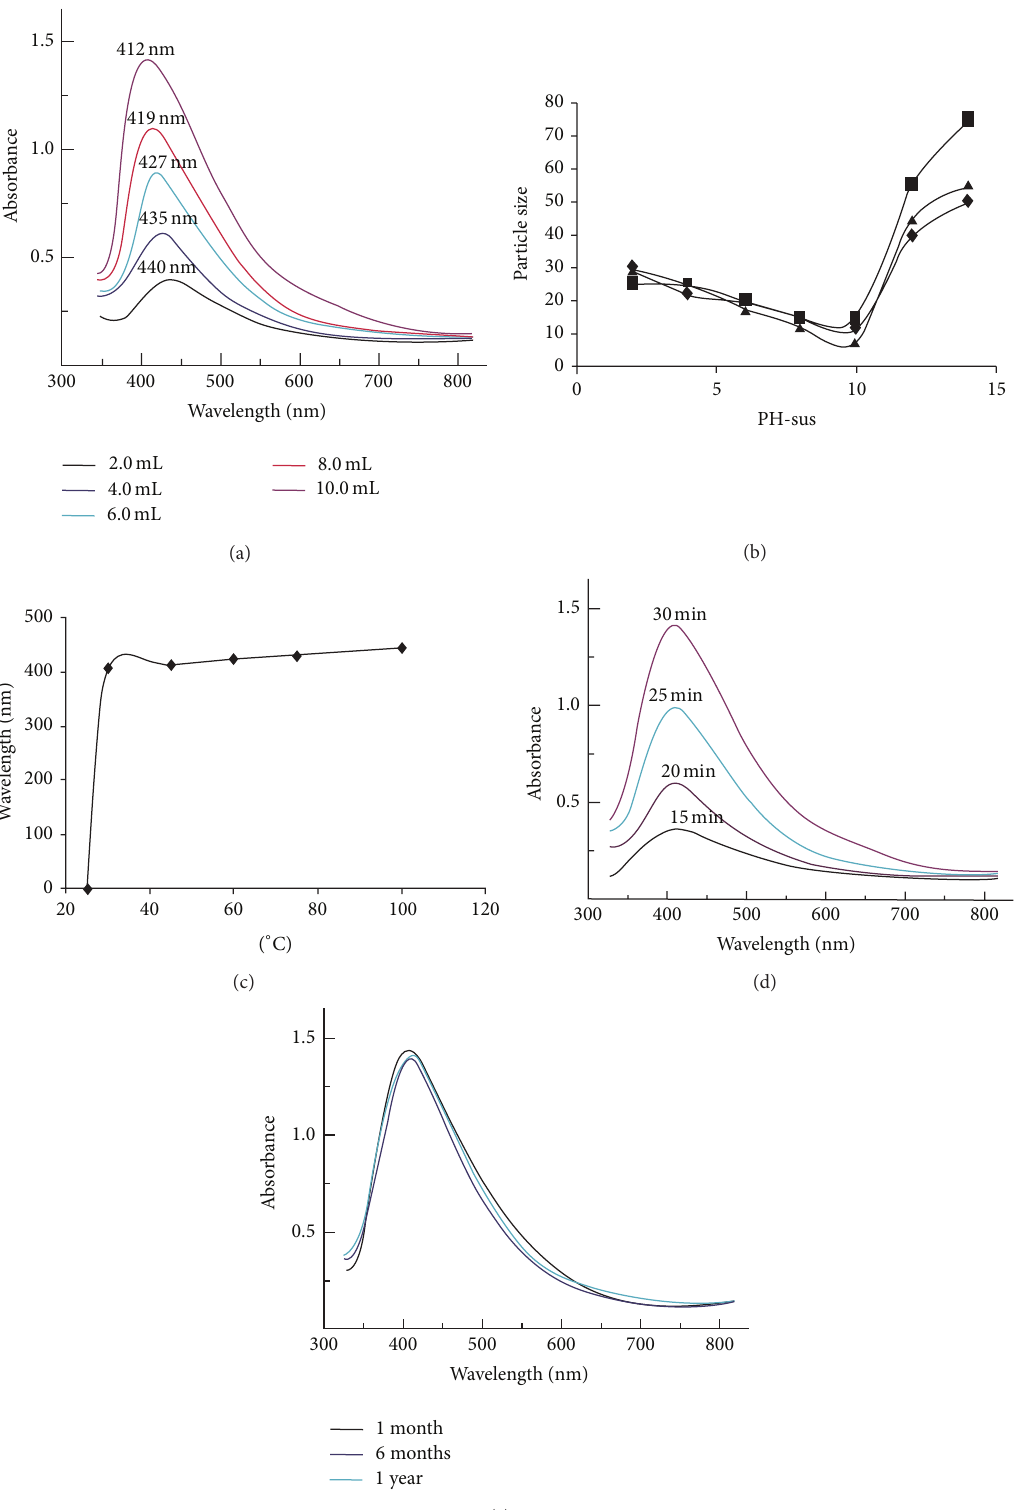
Figure 1: (a) Effect of PH-sus on the SPR of typical sample S 5 , (b) variation of the size of the silver-NPs with PH-sus using different techniques, SPR ( Q ), P-XRD ( ◼ ), and TEM analysis ( 󳵳 ), (c) variation of SPR with temperature (S 5 ), (d) effect of time on the synthesis of sample S 5 , and (e) stability of Ag-NPs versus